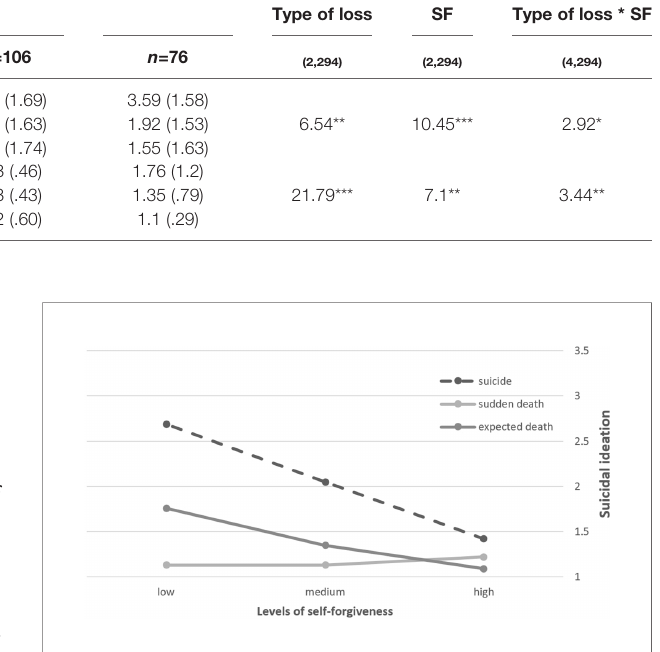
FIGURE 2 | Suicidal ideation as a function of self-forgiveness (SF) and type of loss ( N =